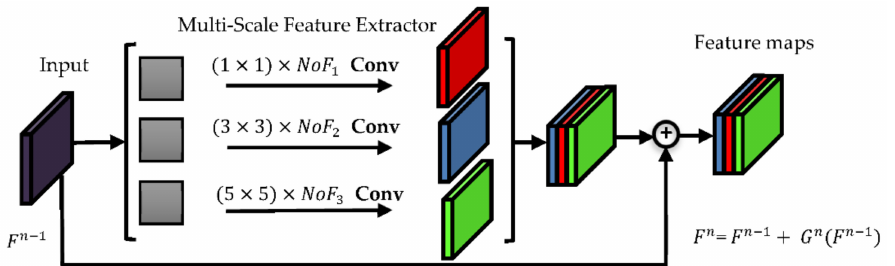
Figure 4. A multi-scale residual